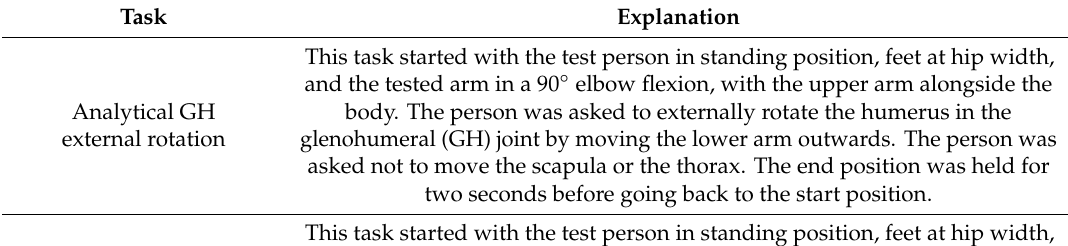
Figure 1. Sensor location and sensor coordinate system. Table 1. Description of the tasks included in the assessment protocol.